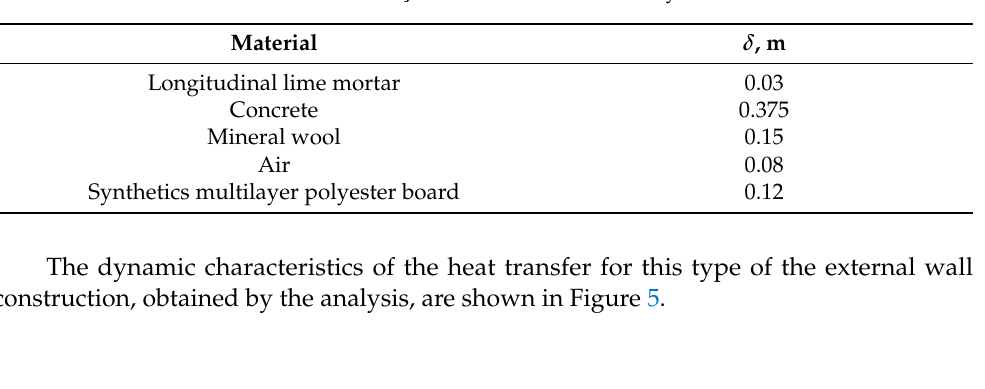
Table 3. External wall of the ventilated façade with the maximum layer